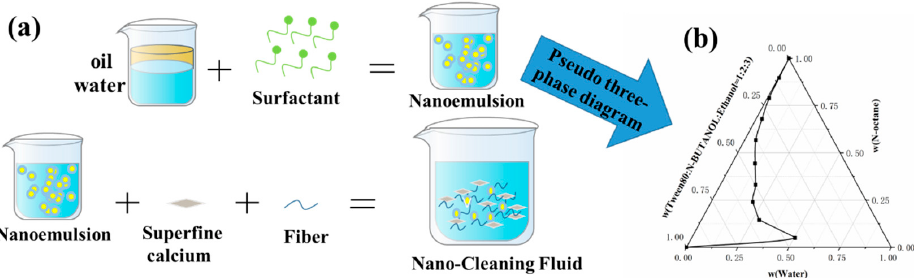
Figure 2. ( a ) Nanoemulsion preparation flow; ( b ) Nanoemulsion pseudo ‐ triple ‐ phase diagram